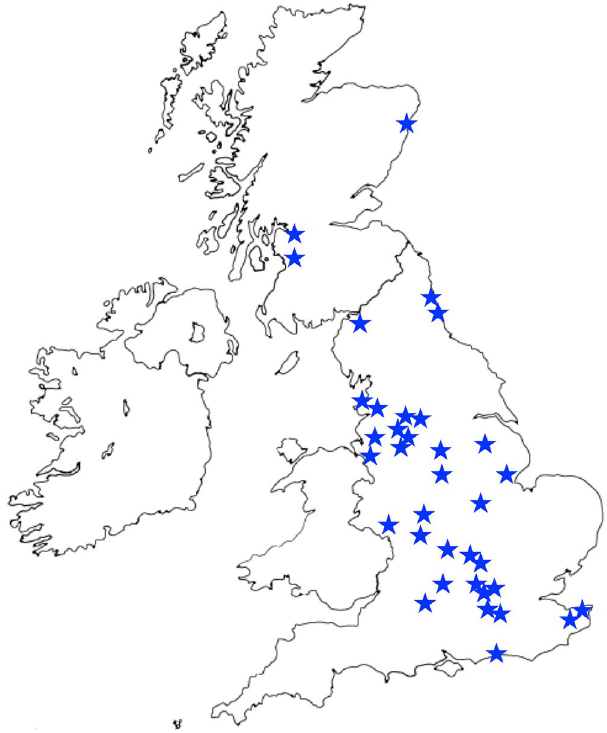
Figure 1. Map of the UK showing recruitment locations for this study, namely hospitals at: Heatherwood, Warwick, Stoke Mandeville, Swindon, Glasgow, Epsom, Northampton, Brighton, Kettering, Derby, Kent, Fairfield, Liverpool. Huddersfield, Chester, Boston, Kings Mill, Manchester, Sunderland, Lincoln, Bradford, Preston, Kidderminister, Worcester, Aberdeen, Kilmarnock, Blackpool, Cumberland, Newcastle, Guildford, Coventry, Milton Keynes, High Wycombe, Oxford, and Wexham Park. Outline map created using InDesign CS6 (8.0) www.adobe.com/products/indesign.html and modified with Powerpoint 2011 products.office.com/en-us/